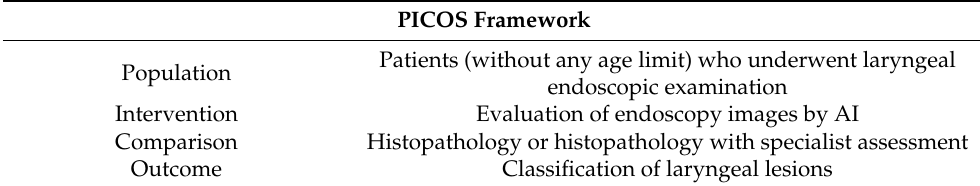
Table 1. Population, Intervention, Comparison, Outcome (PICO).